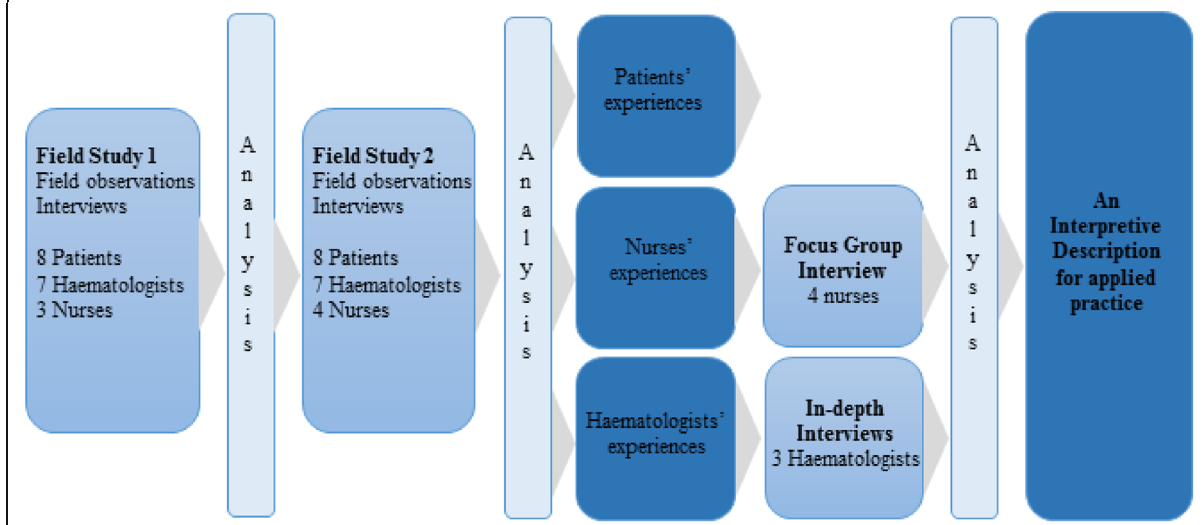
Fig. 1 Illustration of concurrent multi-perspective data